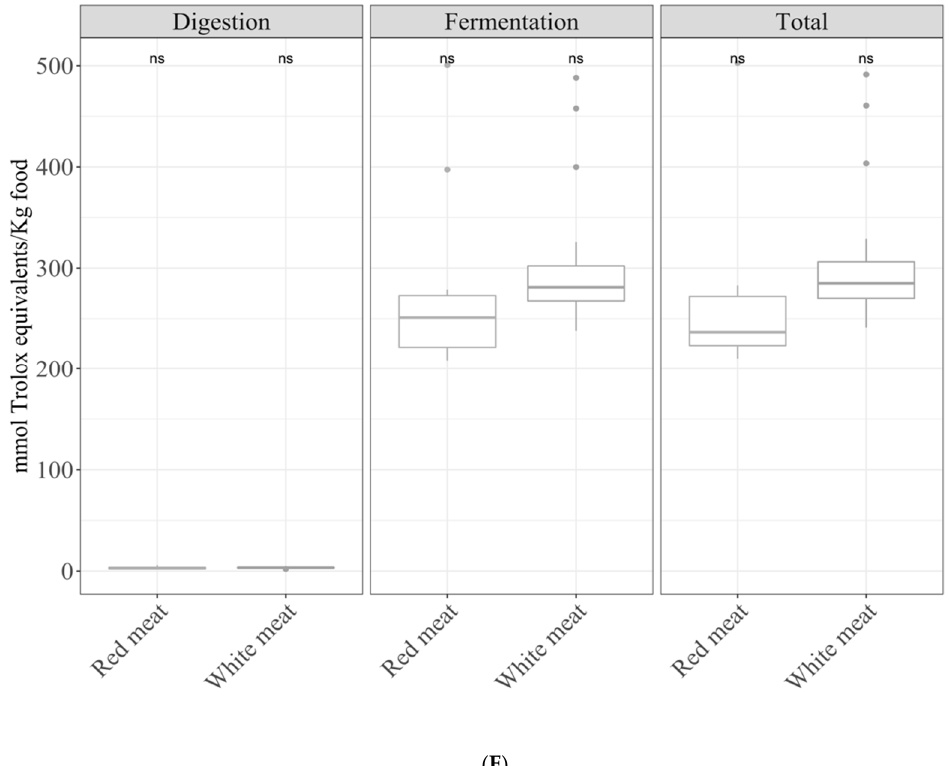
Figure 6. Antioxidant capacity of digested-fermented meat (beef, chicken, lamb, and pork) depending on the cooking technique (( A ) TEAC DPPH , ( B ) TEAC FRAP ), depending on the sample (( C ) TEAC DPPH , ( D ) TEAC FRAP ) and depending of the type of meat, red or white (( E ) TEAC DPPH , ( F ) TEAC FRAP ). Statistical analysis was performed through ANOVA using raw vegetables or mean of all food groups as the reference group. Statistic labels: ***: p < 0.001, ****: p < 0.0001, ns: not significant.